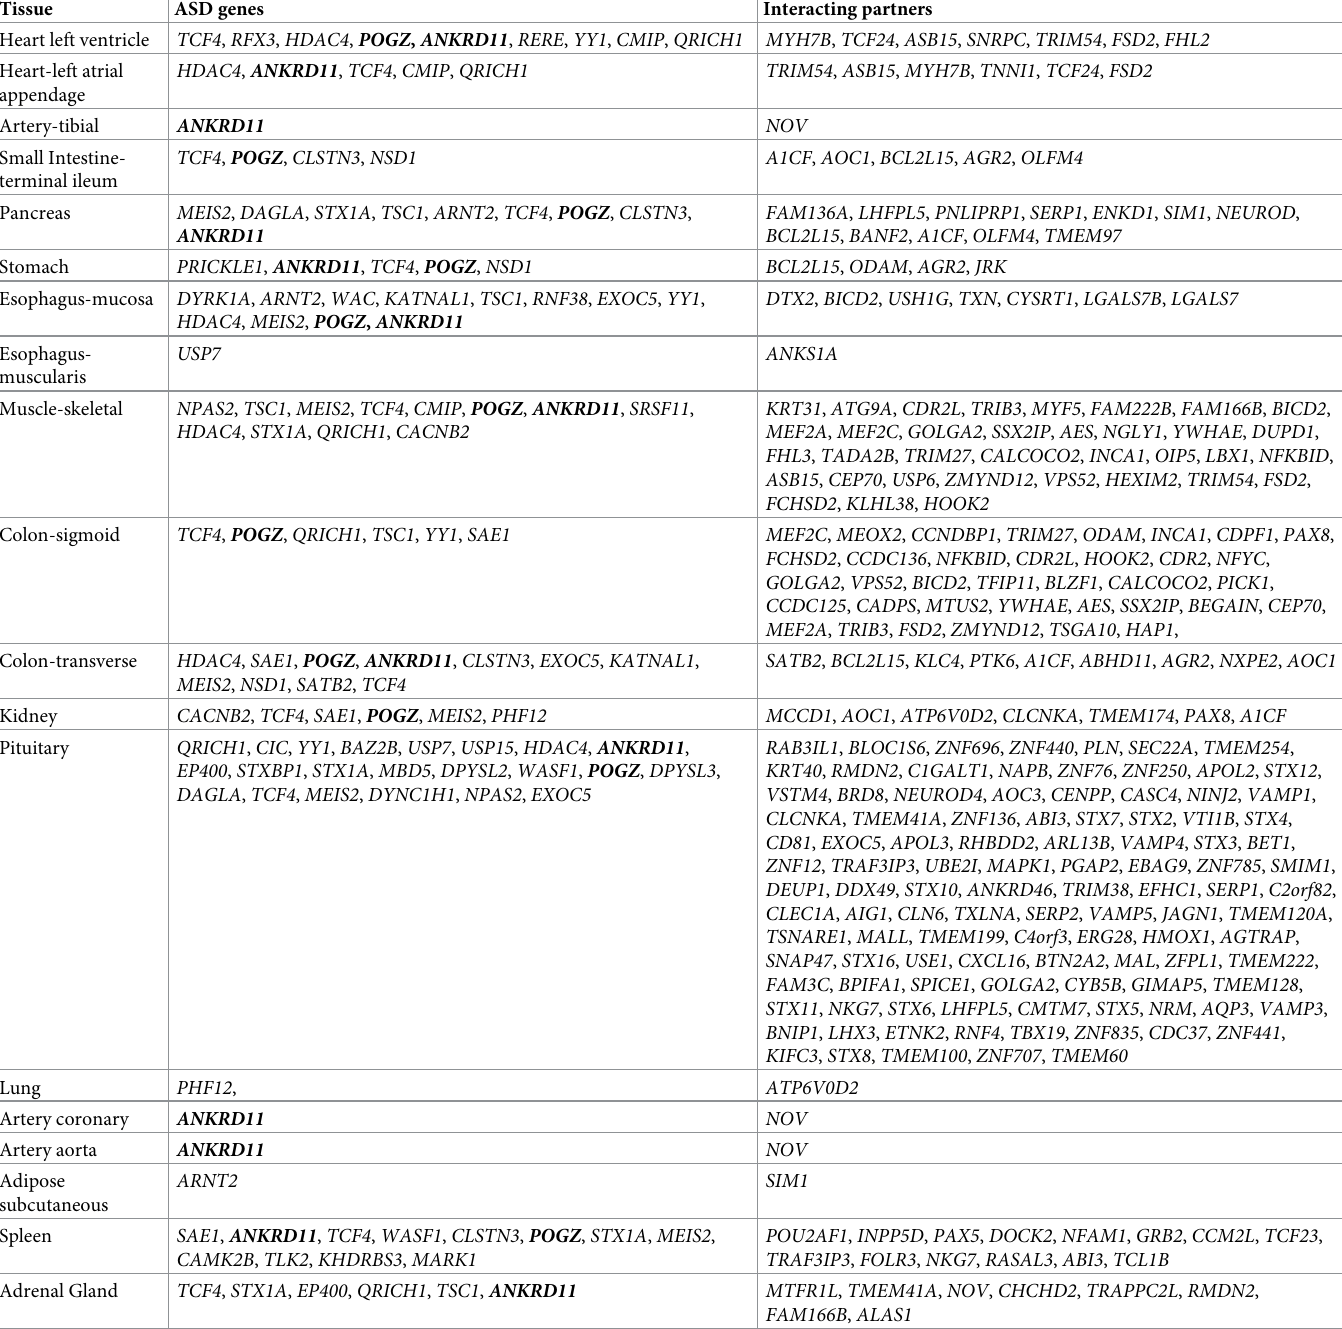
Table 2. Interacting ASD genes in tissue-specific networks. Genes in bold denote ASD genes ( POGZ and ANKRD11 ) present in nearly all networks. Tissue ASD genes Interacting